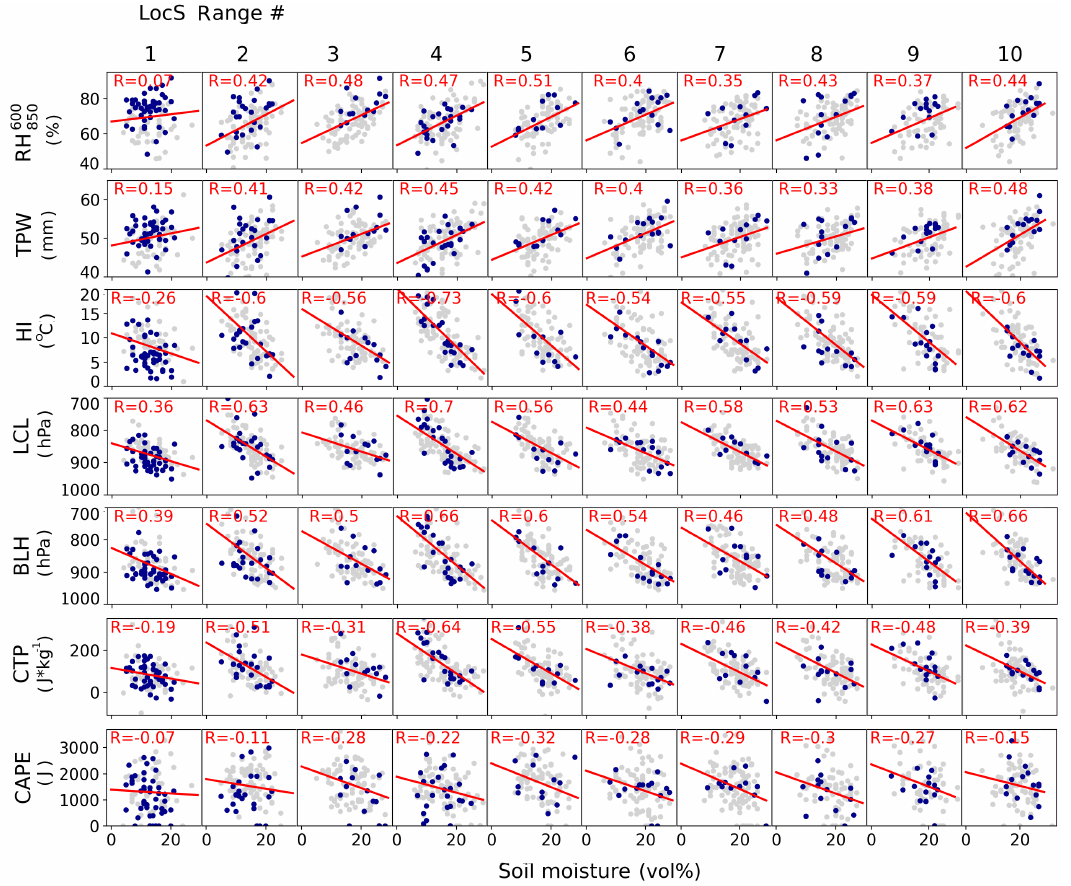
Figure 5. Co-variability of antecedent soil moisture and boundary layer conditions on rain event days. Scatter plots between selected boundary layer parameters at 12 LST and soil moisture at 13:30 LST measured in the AR event Lmax location. The calculations are shown for one of the five African domains (11–12 ◦ N, 8 ◦ W–12 ◦ E) and for every of the 10 heterogeneity ranges. The blue points indicate AR events with an earlier onset time, i.e., at 15 LST. All the other AR events are indicated by gray dots. Boundary layer parameters shown are (from top to bottom) mean Relative Humidity between 850 and 600 hPa (RH), Total column Precipitable Water (TPW), the Humidity Index (HI), Lifting Condensation Level (LCL), Boundary Layer Height (BLH), Convective Triggering Potential (CTP) and Convective Available Potential Energy